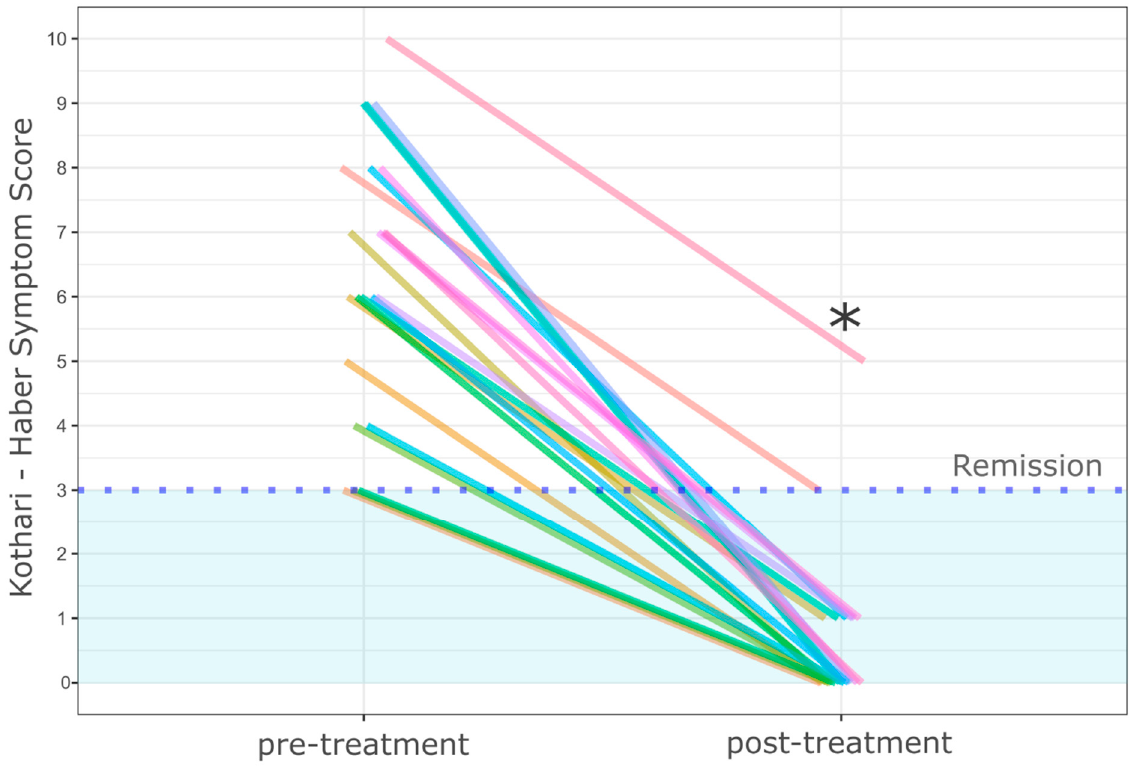
Figure 1. The symptom severity assessed with the Kothari-Haber Scoring System before and after Zenker’s peroral endoscopic myotomy (Z-POEM) treatment. * The patient had recurrent ZD after previous treatment and his septum did not collapse after complete Z-POEM, most likely due to severe fibrosis. The symptoms completely resolved (KHSS 0 points) after subsequent septotomy of the fibrotic mucosal septum. Each line represents different patient.